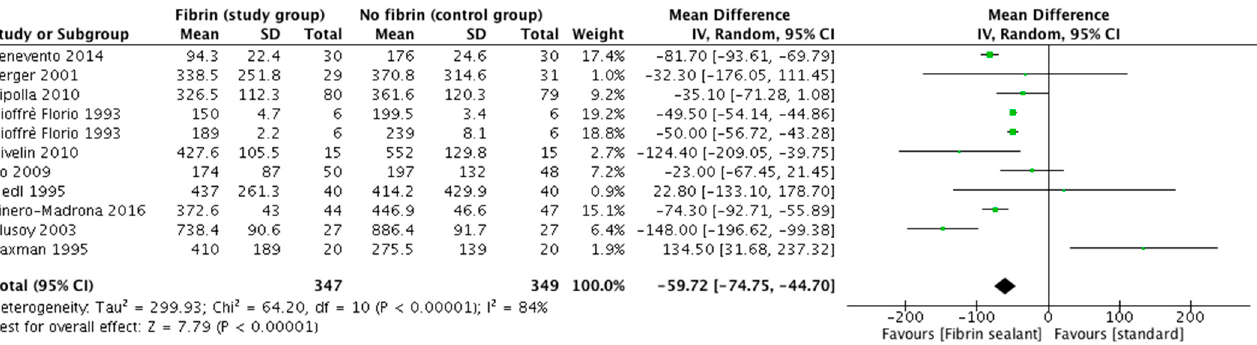
Figure 3. Axillary drainage output. The value reported for the axillary drainage output refers to the mean total drainage volume, in mL, +/ − standard deviation.